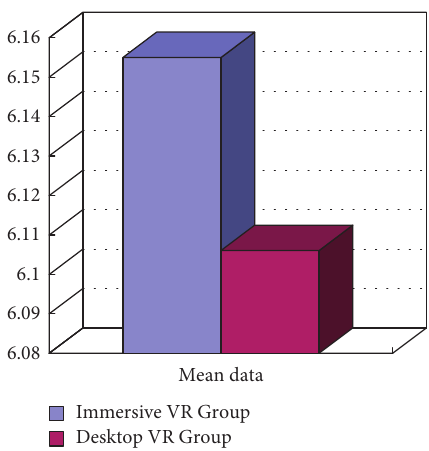
Figure 8: Descriptive statistics of posttest intrinsic motivation.